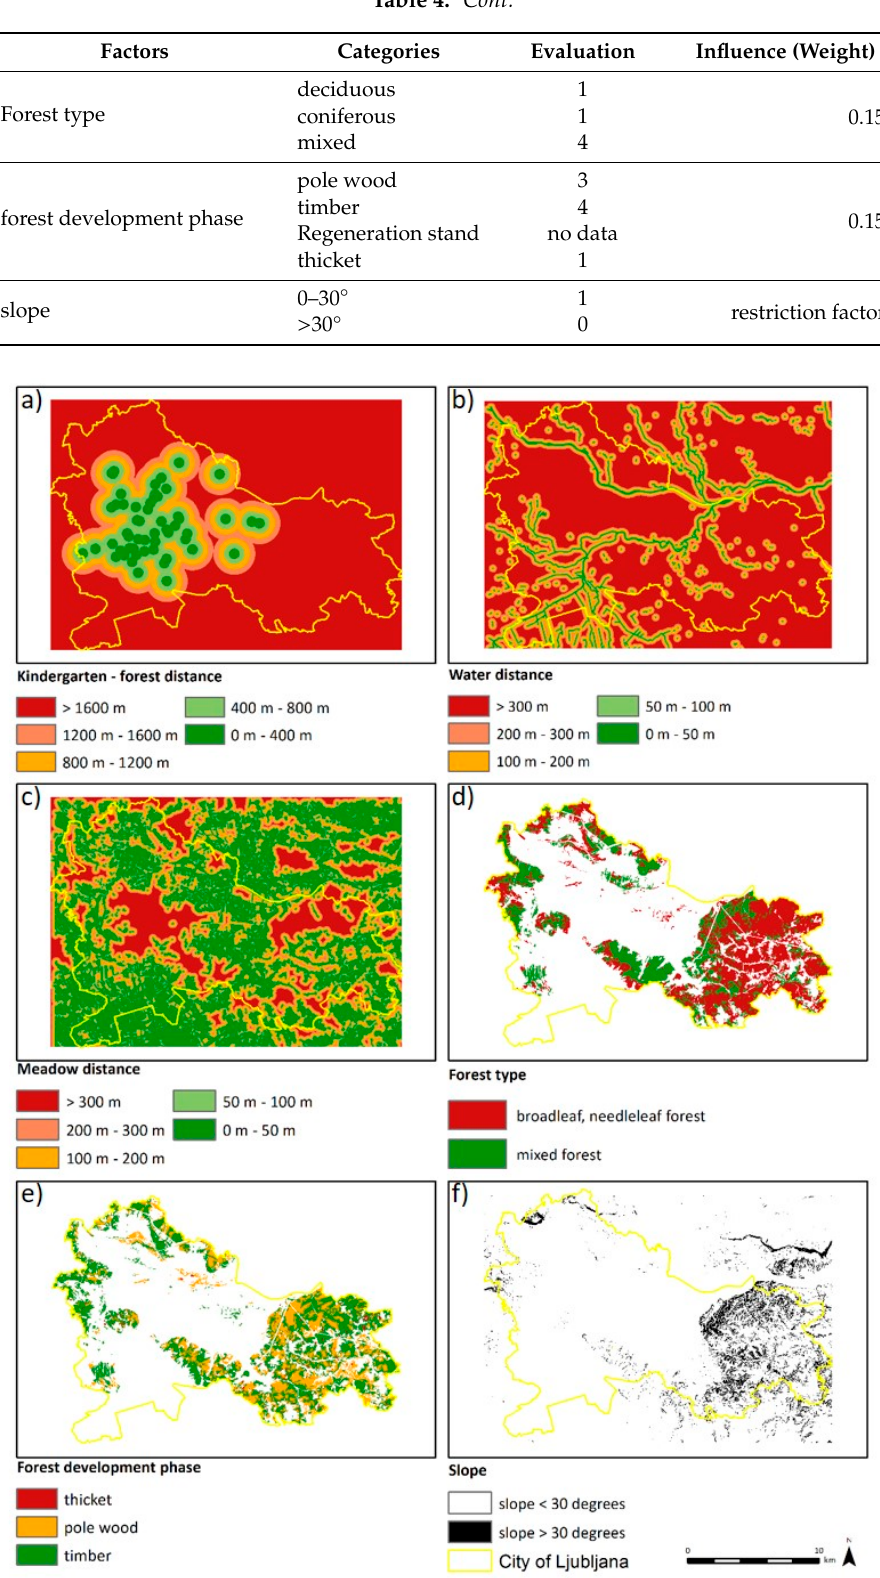
Figure 4. The factors used in the model of forest suitability for a visit with kindergarten groups of children with categories. ( a ) Kindergarten – forest distance, ( b ) Water distance, ( c ) Meadow distance, ( d ) Forest type, ( e ) Forest development phase, ( f ) Slope.